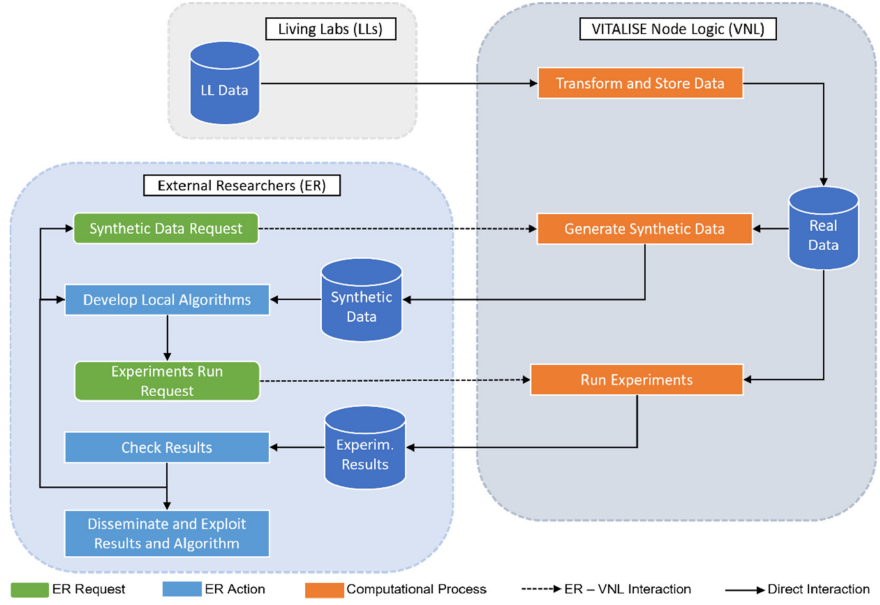
Figure 1. VITALISE LL controlled data processing workflow